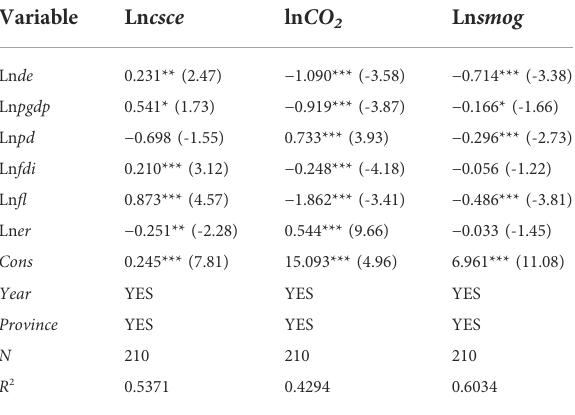
TABLE 2 Baseline regression coef fi cients of the digital economy on the synergistic management of carbon and haze